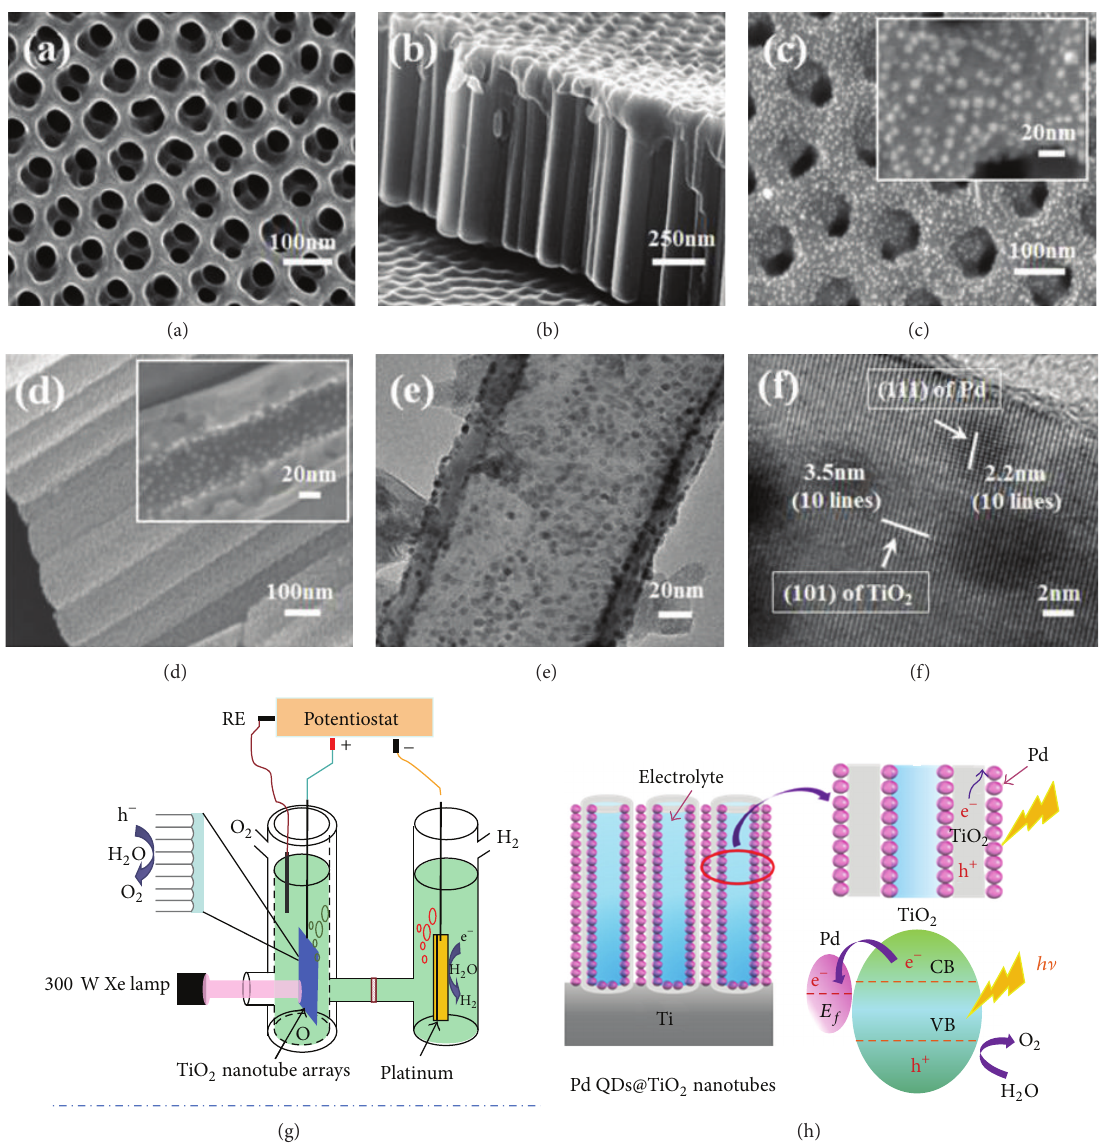
Figure 9: Top and cross-sectional SEM images of pure TNAs ((a), (b)) and Pd QDs@TNAs ((c), (d)). The insets show the corresponding magnified images. TEM images of TNAs coated with Pd QDs. (g) Schematic of TNAs on photoelectrolytic water splitting for hydrogen production. (h) Schematic illustration of TNAs deposited with Pd QDs and the charge transfer process from TiO 2 to Pd (lower right